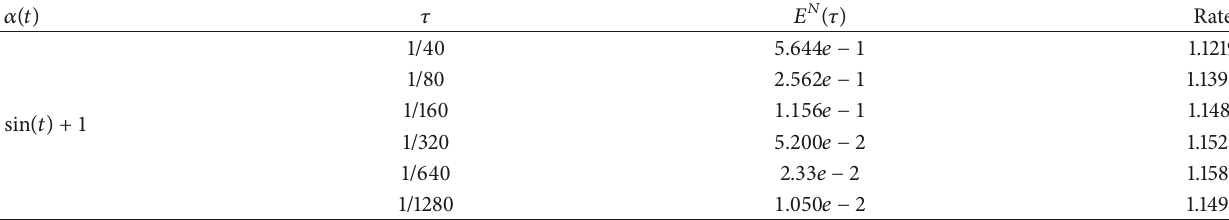
Table 8: Maximum errors and convergence rates for Example 2 at 𝑇 = 1 and 𝜎 5 = 𝜎 + 0.2 . 𝛼(𝑡)